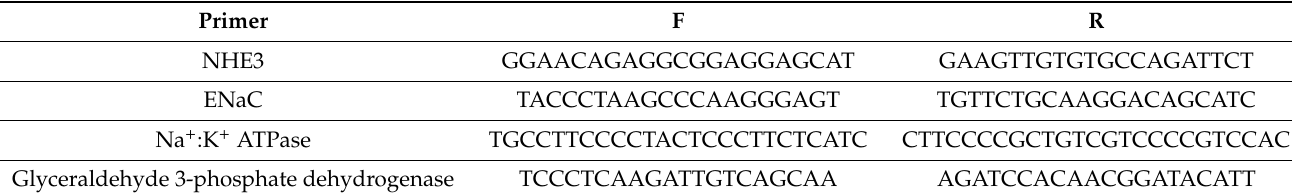
Table 1. Primers for real-time